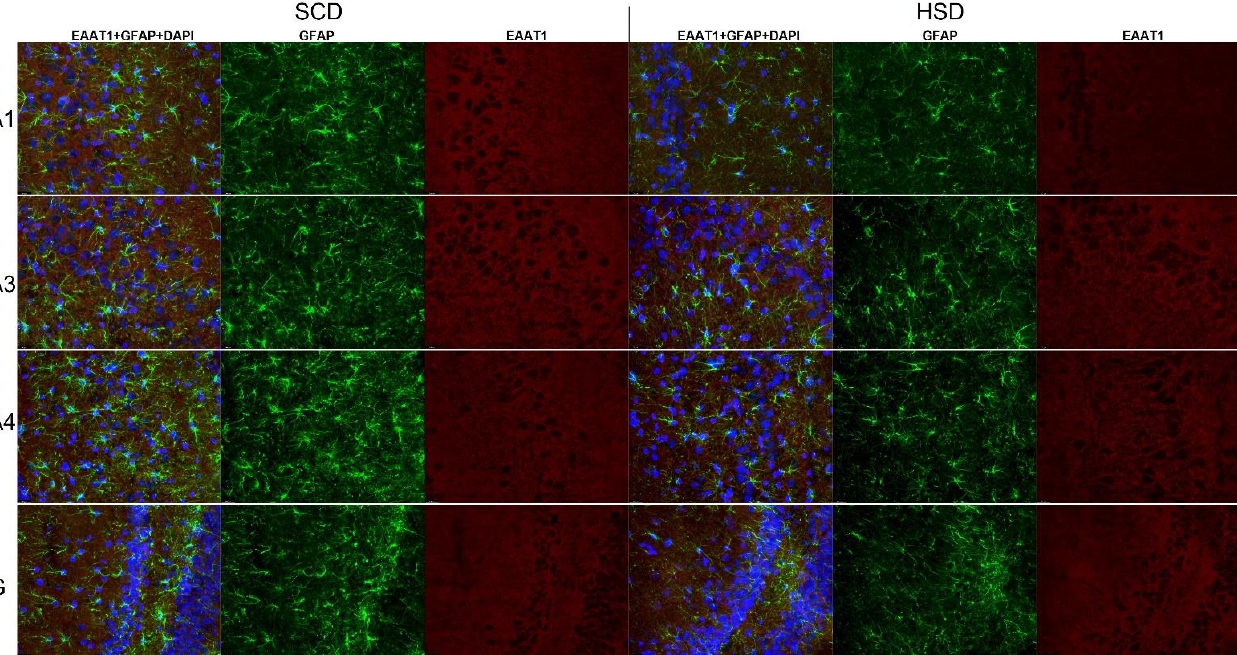
Figure 8. Immunohistofluorescence staining of EAAT1 localization on astrocytes in the HIP of female offspring. Representative images showing EAAT1 immunoreactivity (red) in GFAP positive astrocytes (green) with DAPI-stained nuclei (blue). n = 6 in each group. Magnification × 40, scale bar 20 μm.